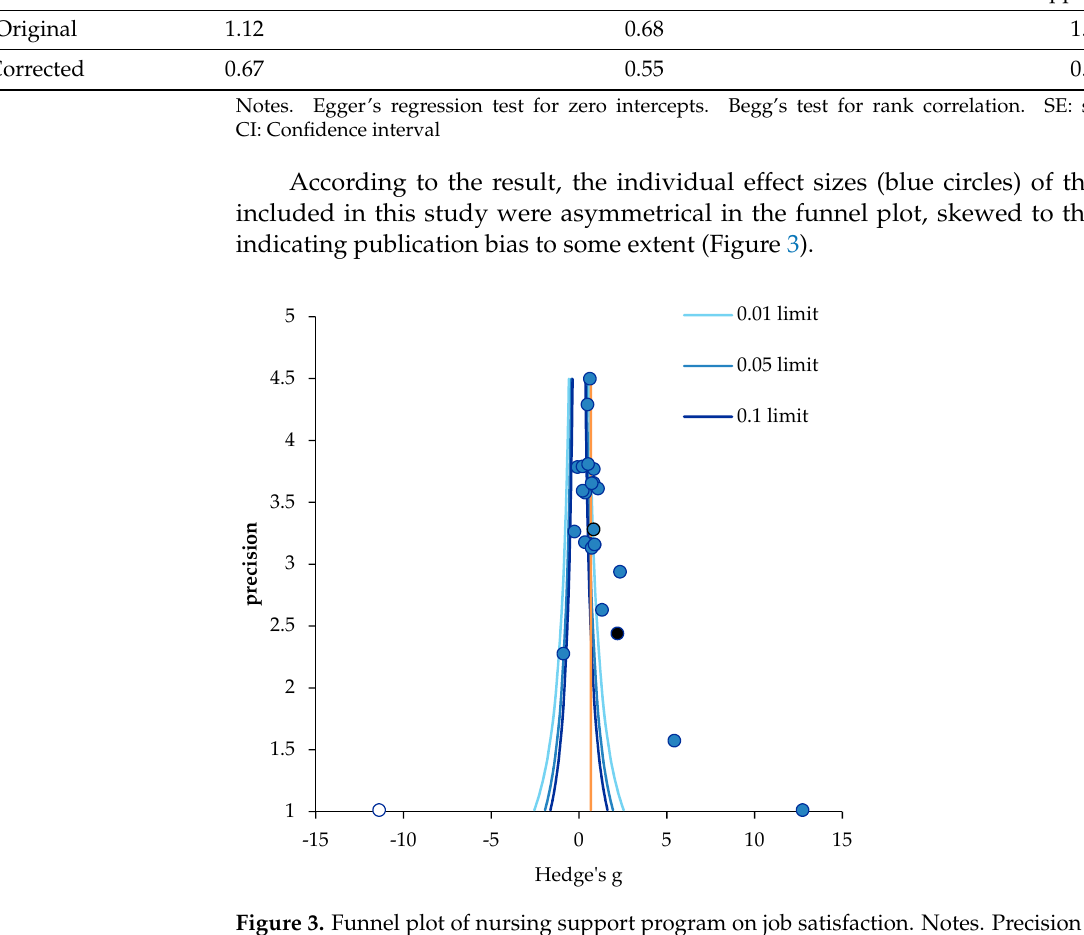
Figure 3. Funnel plot of nursing support program on job satisfaction. Notes. Precision = 1/standard error; 0.05; limit line = 95% confidence limit.